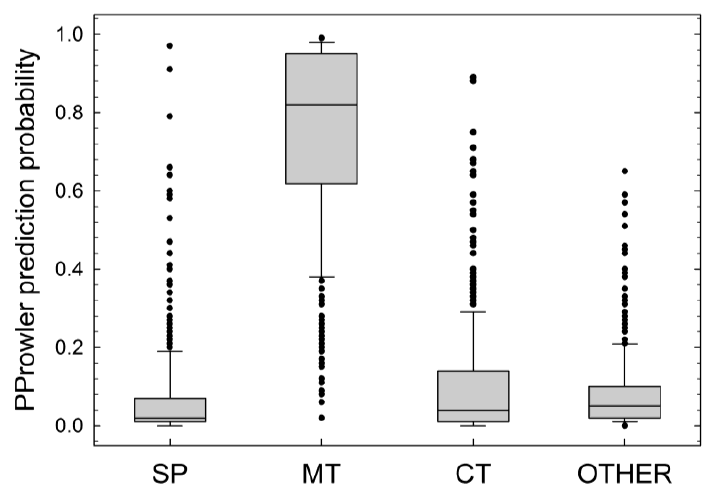
Figure 1. Subcellular prediction for proteins of the LEA_3 family. The graph shows the probability of subcellular targeting for 390 proteins of the LEA_3 family to different compartments (SP, secretory pathway; MT, mitochondria targeting; CT, chloroplast targeting) according to the PProwler software. Peroxisomal targeting probability is not indicated (null for all proteins). The 390 proteins selected are the best matches retrieved using the LEA38 protein sequence as the query in a BLASTP search against the NCBI Reference Sequence protein database, and all belong to the LEA_3 family. The boundary of the box closest to zero indicates the 25th percentile, a line within the box marks the median, and the boundary of the box farthest from zero indicates the 75th percentile. Whiskers (error bars) above and below the box indicate the 90th and 10th percentile, respectively.